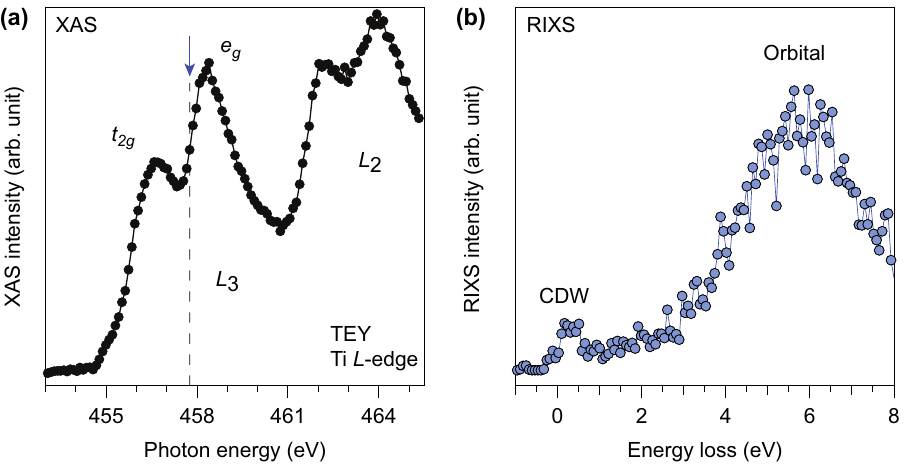
Figure 2. XAS and RIXS on TiSe 2 taken with X-ray FEL. ( a ) X-ray absorption spectrum (XAS) across the Ti L 3 - and L 2 -edge measured by the total fluorescence yield. At the Ti L 3 -edge, two main peaks are separated into t 2g and e g manifolds due to the crystal field splitting. ( b ) A representative X-ray FEL RIXS spectrum measured with incident photon energy indicated by the blue arrow in ( a ) before time zero. The low energy feature around ~ 0.4 eV is attributed to particle-hole excitations across the CDW gap and is denoted by “CDW”. Orbital excitations in the spectrum are denoted by